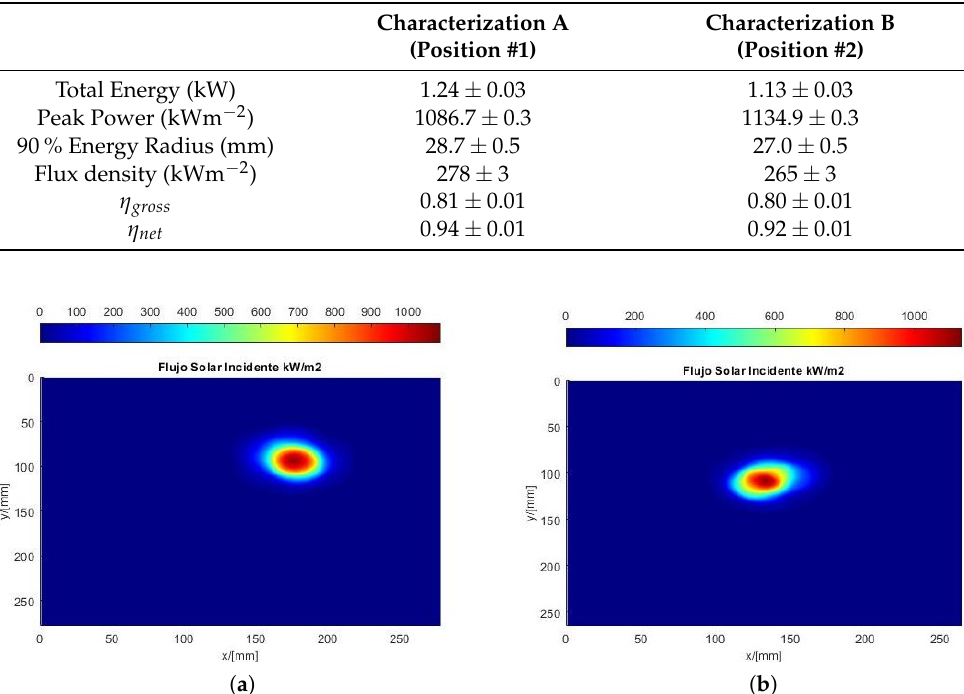
Figure 6. Energy calibration of the Fresnel lens installed in the solar furnace: (red line) in position #1 (characterization A); and (blue line) in position #2 (characterization B). Table 1. Results of the energy characterization for both positions (#1 and #2) of the Fresnel lens.